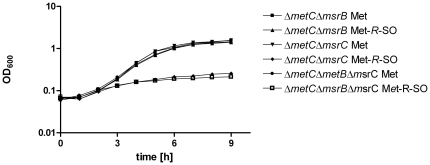
Growth of methionine auxotrophic mutants with deletions in msrB and msrC on methionine and free Met-R-SO.Bacteria were grown overnight in LB, harvested, washed and cultivated in M9 minimal medium supplemented with 13 µg ml−1methionine (Met) or methionine-R-sulfoxide (Met-R-SO) (MOLISA), respectively, started at an optical density (OD600) of 0.05. Growth of ΔmetCΔmsrB, ΔmetCΔmsrC and ΔmetCΔmsrBΔmsrC was observed by measurement of OD600 every hour for nine hours of cultivation. Experiments were done in triplicates. Means are shown ± standard deviation.